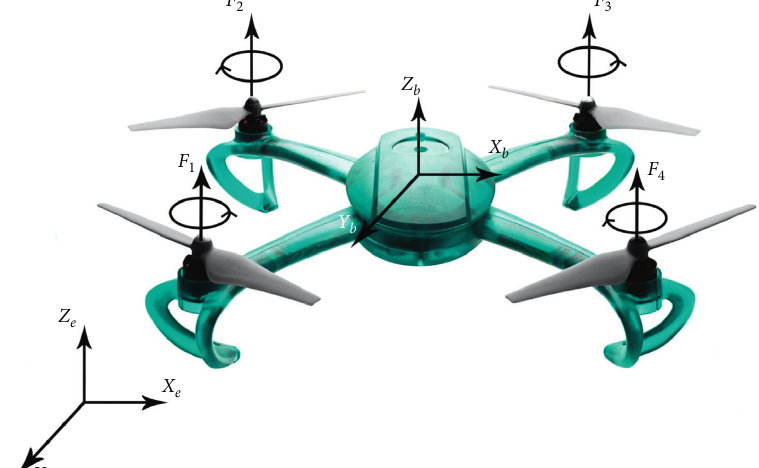
Figure 1: Schematic of the quadrotor